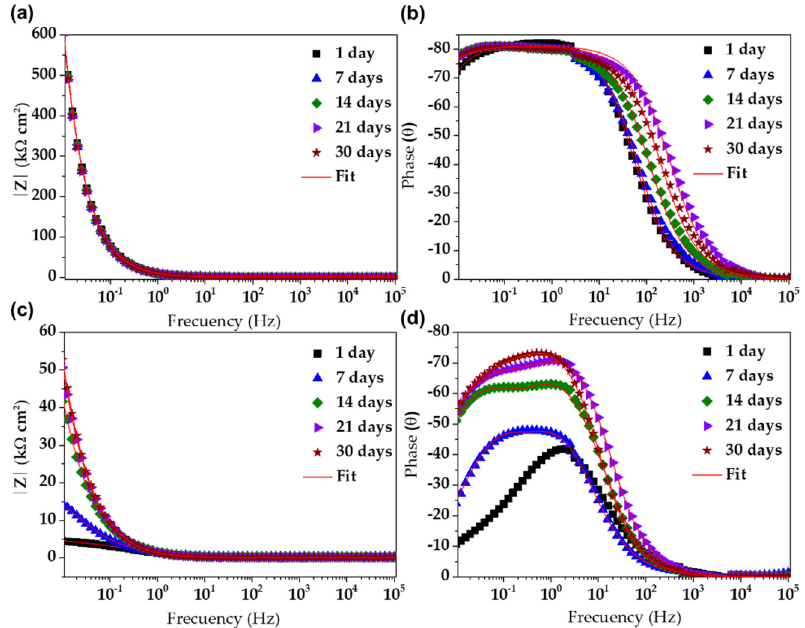
Figure 8. EIS Bode diagrams with a respective fitting line for SS430 ( a , b ) and carbon steel B450C ( c , d ) after different times of immersion in SS1 cement extract solution.